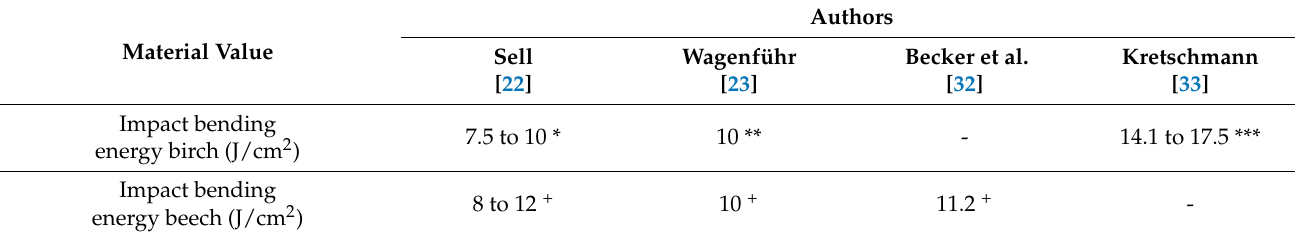
Table 2. Average ranges of impact bending energy values for small clear wood specimens of birch and